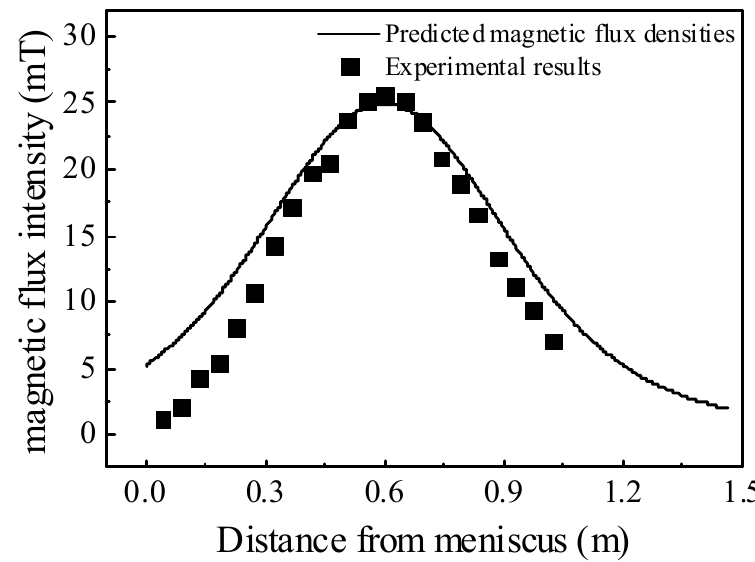
Figure 4. Simulated and measured results of the magnetic flux intensity. (3) Solidification model